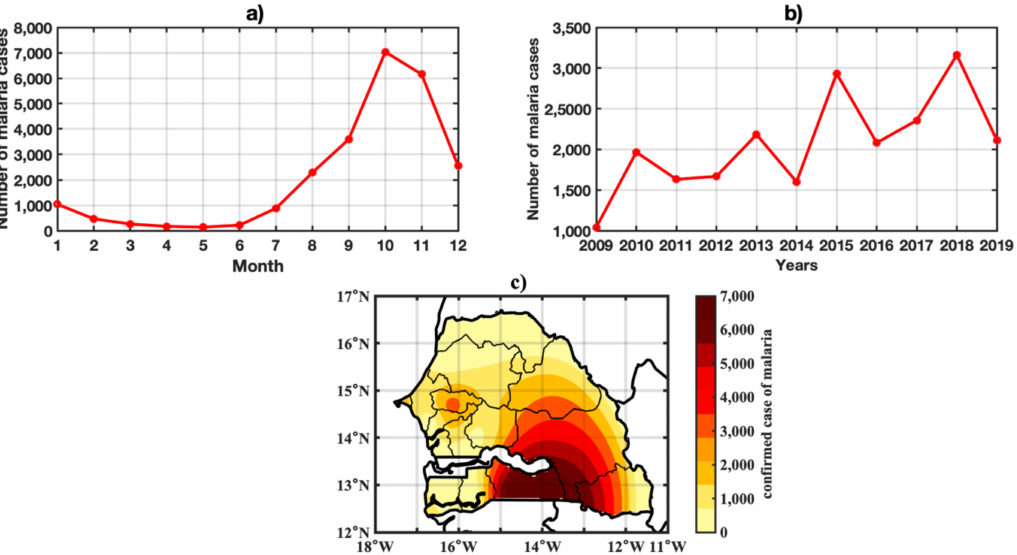
Figure 5. Spatio-temporal variability in the number of confirmed malaria cases in Senegal from 2009–2019: annual cycle ( a ), interannual variability ( b ), and spatial distribution of confirmed malaria cases ( c